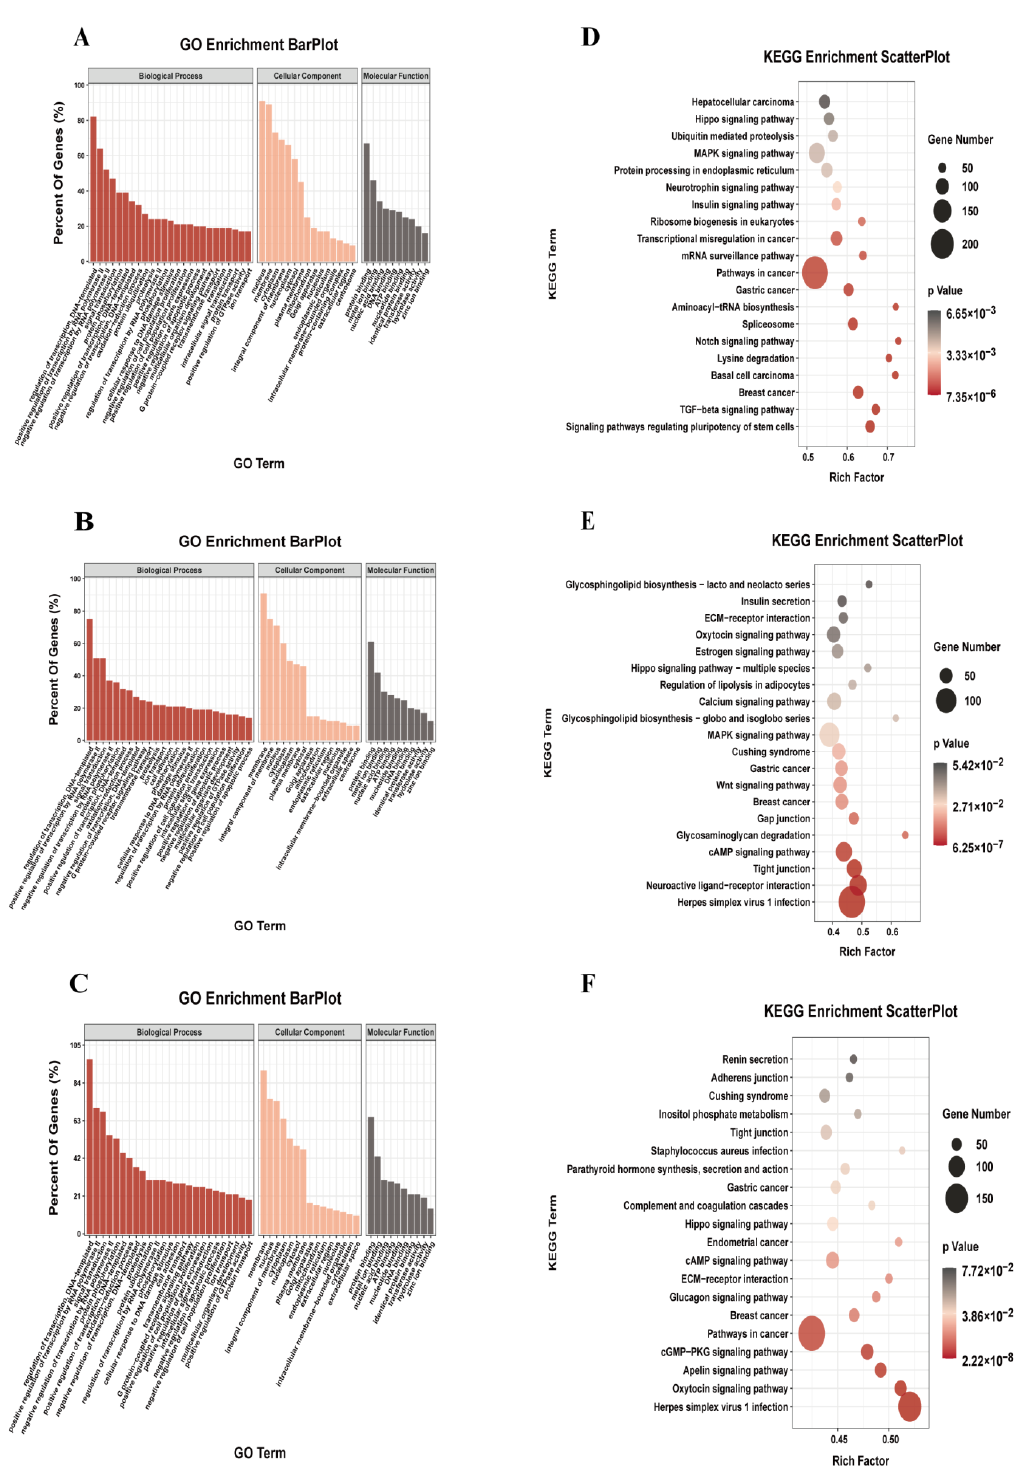
Figure 3. Functional analysis of genes associated with m6A peaks. ( A ) GO analysis of common genes associated with m6A peaks in NBY and DA. ( B ) Gene ontology analysis of unique genes associated with m6A peaks in NBY. ( C ) Gene ontology analysis of unique genes associated with m6A peaks in DA. ( D ) KEGG analysis of common genes associated with m6A peaks in NBY and DA. ( E ) KEGG analysis of unique genes associated with m6A peaks in NBY. ( F ) KEGG analysis of unique genes associated with m6A peaks in